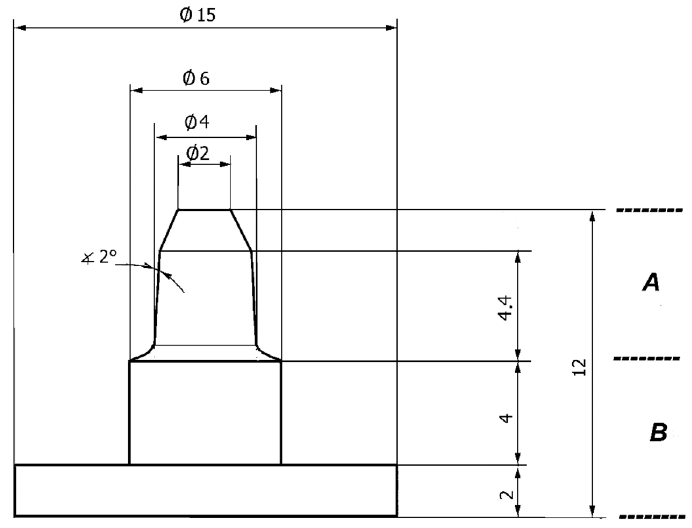
Figure 1. Schematic portrayal of the metal base part used in all cases (dimensions in mm); ( A ) part supporting the primary crown; ( B ) connection area to the material testing device.